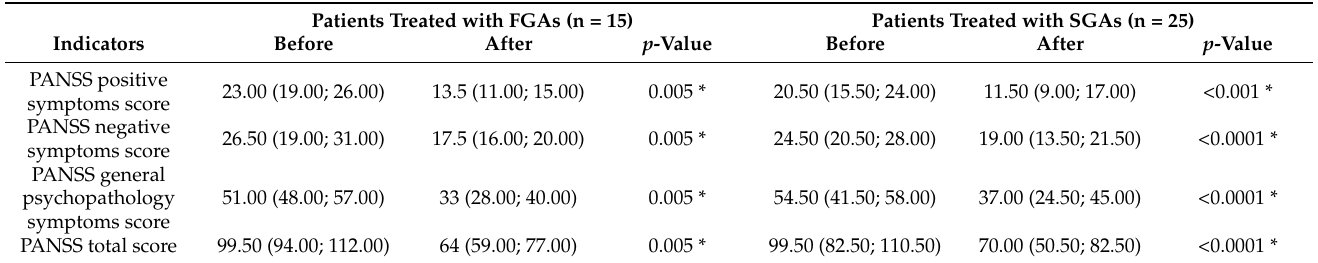
Table 2. Clinical characteristics of patients with schizophrenia before and after therapy, depending on antipsychotic